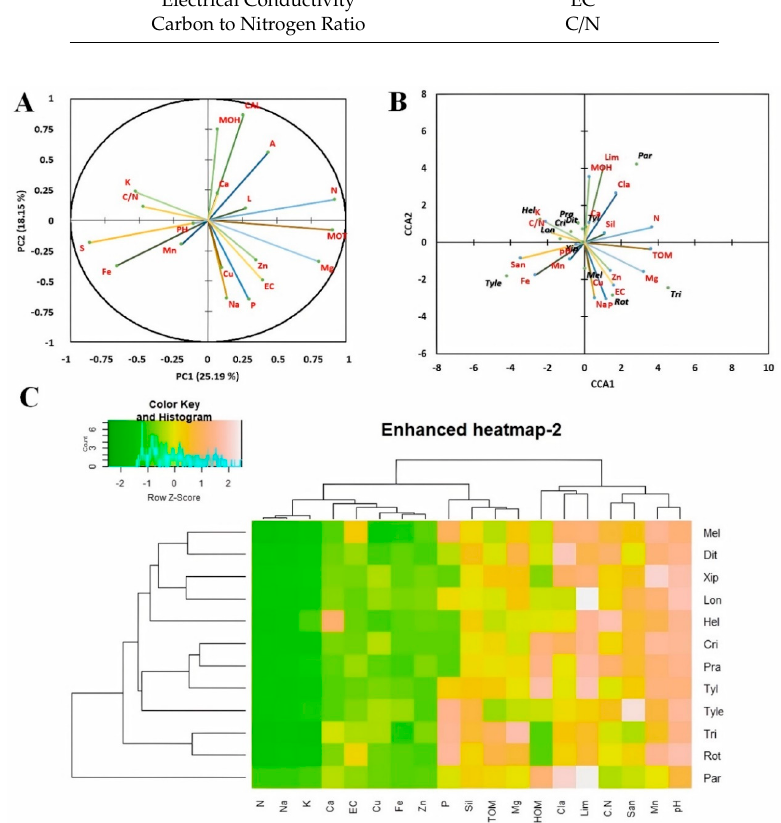
Figure 7. Physico-chemical soil characteristics in all organic farming systems surveyed. ( A ) PCA loading plot for the soil characteristics. ( B ) Canonical correspondence analysis (CCA) showing the relationship between nematode communities of organic crops and soil properties. ( C ) Advanced heatmap (enhanced heatmap-2) showing the population structure of nematode genera in organic crop fields in different farming systems surveyed. Ward’s clustering algorithm was applied to the Spearman dissimilarity matrix of nematode distribution in organic crop fields in interaction with physico-chemical soil characteristics. The upper dendrogram represents soil patterns. The left dendrogram represents the nematode genera. The color key scale represents the normalized Row Z-score of nematode abundance (per 100 cm 3 of soil). Genus and soil codes are given in Table 1; Table 6.